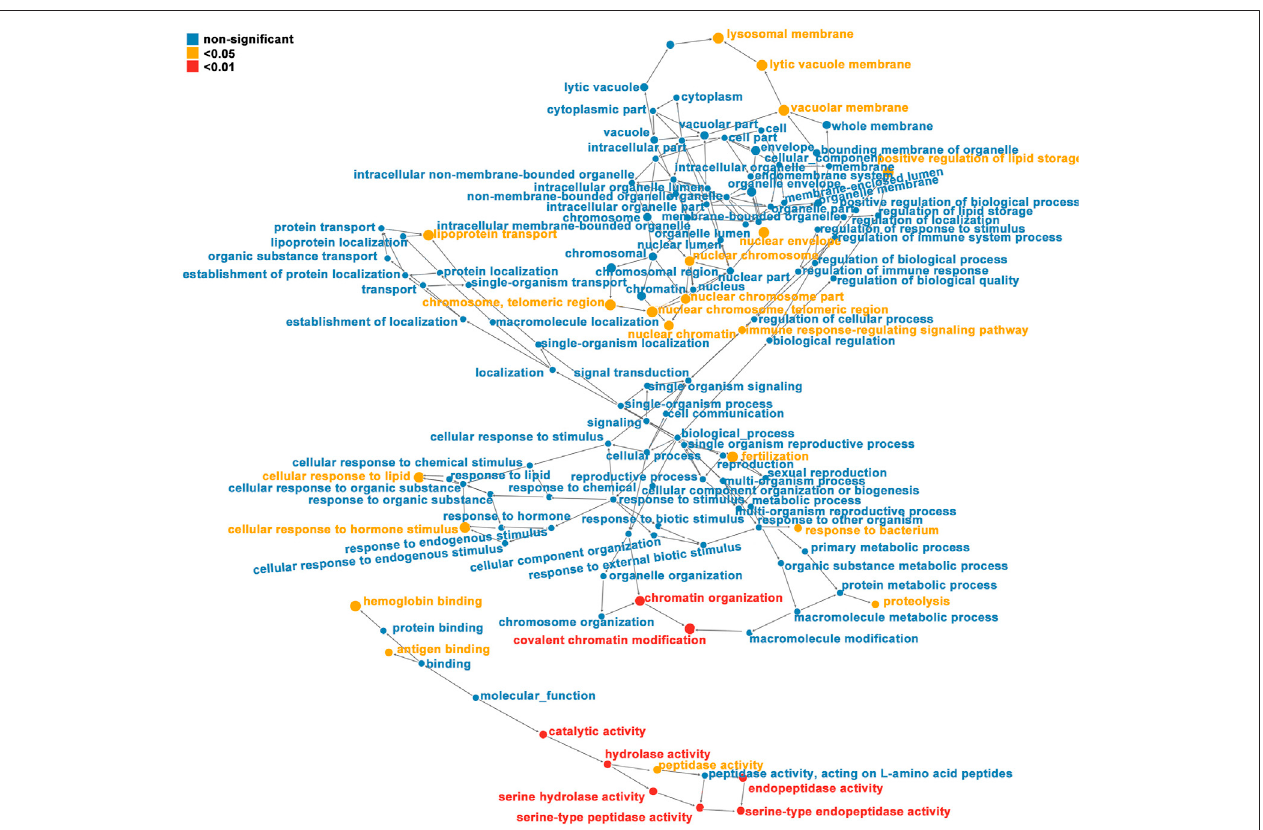
FIGURE 4 | Directed acyclic graph (DAG) of each GO category for proteins corresponding to differentially expressed modi fi cation sites (red indicates that the differentially modi fi ed protein is extremely signi fi cant ( p < 0.01) enriched in GO classi fi cation, yellow represents differentially modi fi ed protein ( p < 0.05) enriched GO classi fi cation, and blue represents non-signi fi cantly enriched GO classi fi cation. The upper and lower levels of the GO classi fi cation; the size of the circle represents the degree of enrichment.